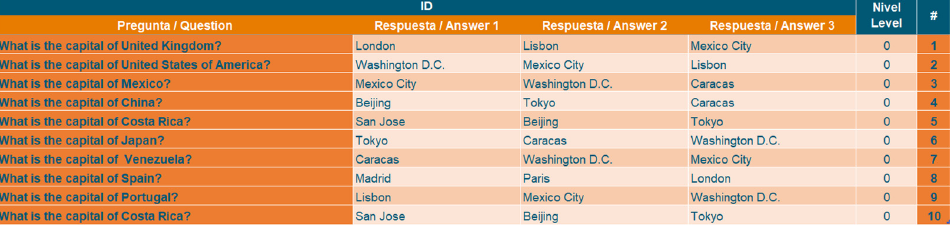
Table 5. Comparison of question types.